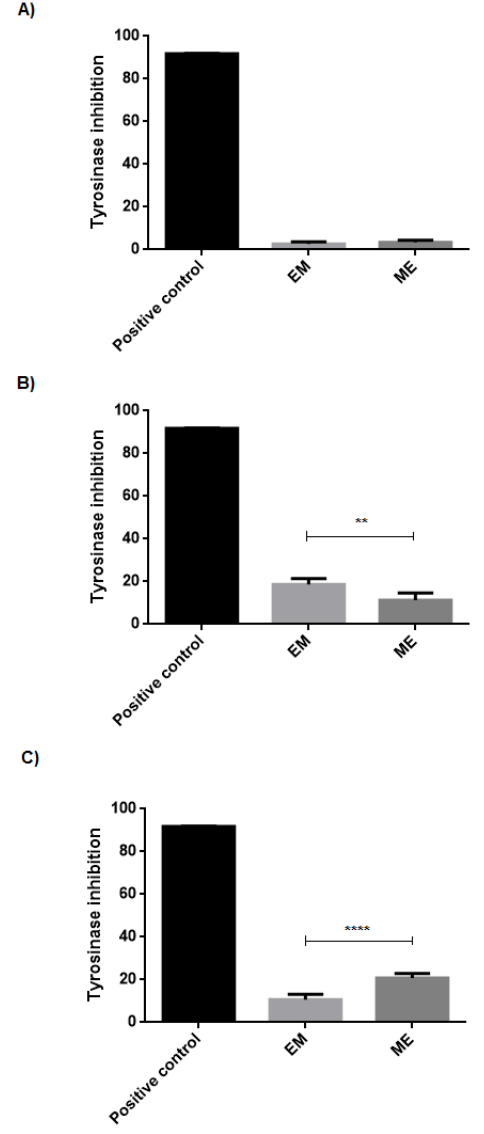
Figure 9. Tyrosinase inhibition by EXT contained in conventional emulsion (EM) and microemul- sion ME at ( A ) receptor solution, ( B ) stratum corneum, and ( C ) remaining skin, after 6 h of in vitro skin permeation assay. Each bar represents an average of four determinations ± SD. ** p < 0.01; **** p < 0.0001.